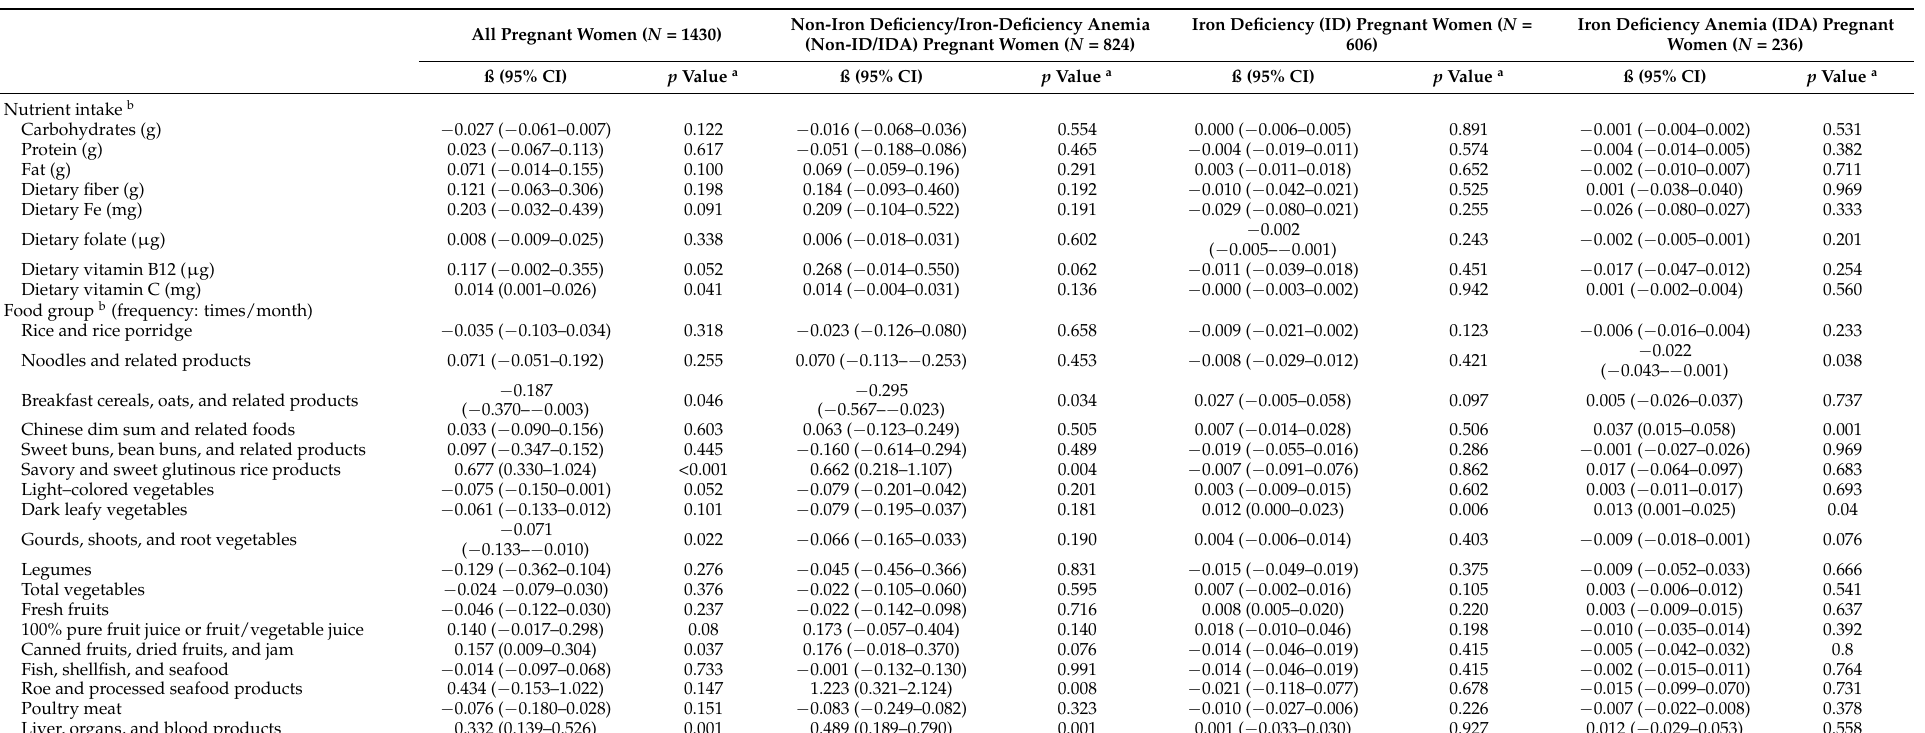
Table 3. Adjusted beta coefficient (ß) and 95% confidence interval (CI) of gestational serum hepcidin levels for nutrients and food groups among pregnant women. All Pregnant Women ( N =